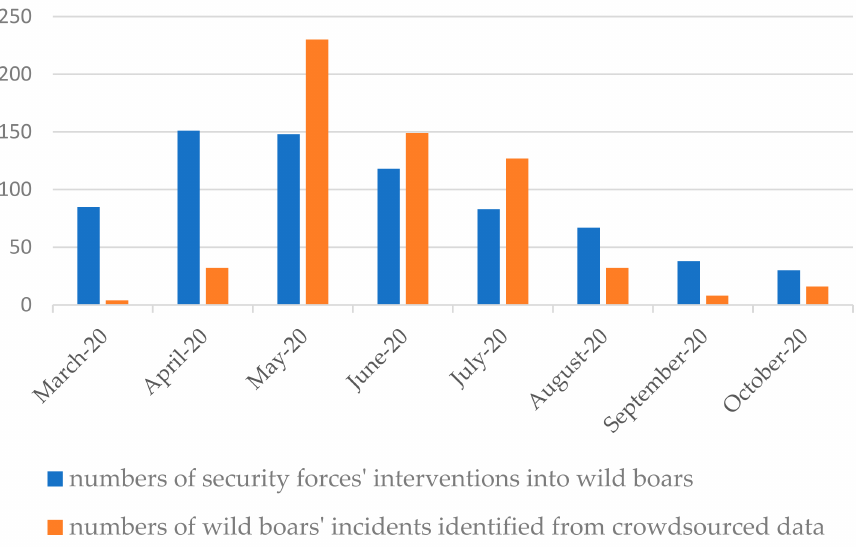
Figure 9. Comparison of the number of wild boar incidents from security forces’ interventions reports and social media data. Source: own